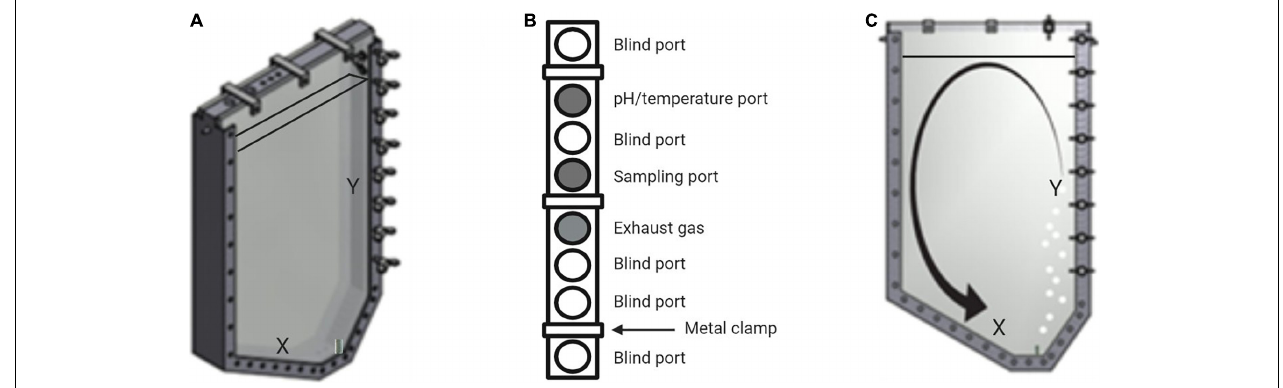
FIGURE 1 | Schematic view of the novel flat panel gas-lift photobioreactor. (A) Frontal view of the photobioreactor. X indicates the sloping edge, while Y illustrates the area of maximum buoyancy above the sparger. These two characteristics are responsible for adequate flow formation and prevention of dead zones. The fill level line indicates a volume of 7.2 L. (B) Top view of the eight inlet ports of the reactor. Three metal clamps seal the upper part of the device. For this study, only the three shaded inlets were used for pH- and temperature measurements, sampling and for gas exhaust. (C) Schematic medium flow within the bioreactor. The gas input via the sparger results in a buoyancy at Y. The sloping edge X pushes the liquid stream toward the sparger, resulting in a circular confection that inhibits sedimenting of biomass.